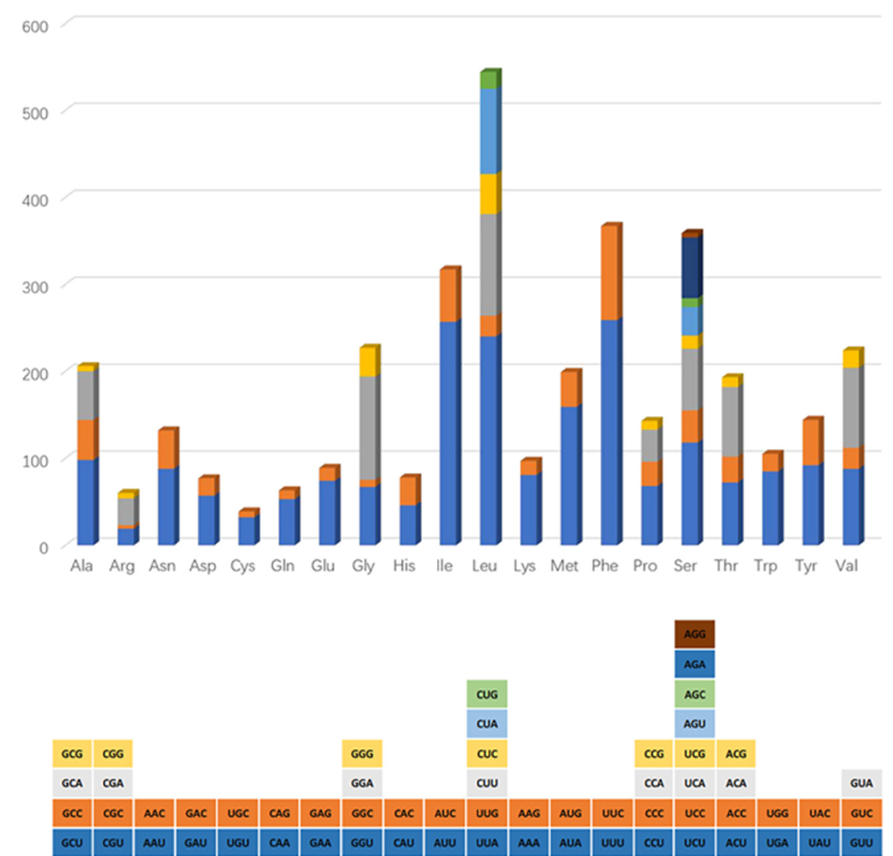
Figure 2. Codon usage among the 13 mitochondrial protein-coding genes of M. coccopoma . Table 3. Nucleotide composition and skew of M. coccopoma mitochondrial